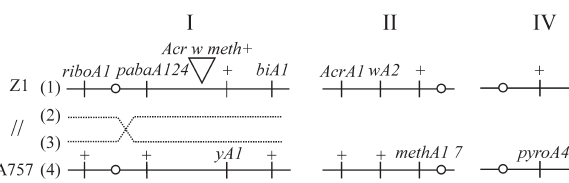
Figure 5 - Schematic representation of chromosome I of the D2 diploid. Segregation of the parental (4) and the recombinant (2) chromatids to- wards the same mitotic pole results in the paba+, y, bi+ // paba+, y,